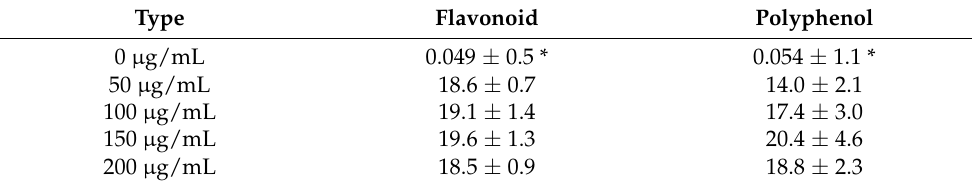
Table 1. Concentration ( µ g/mL) of flavonoid and polyphenol in Paeonia lactiflora extract. Type Flavonoid